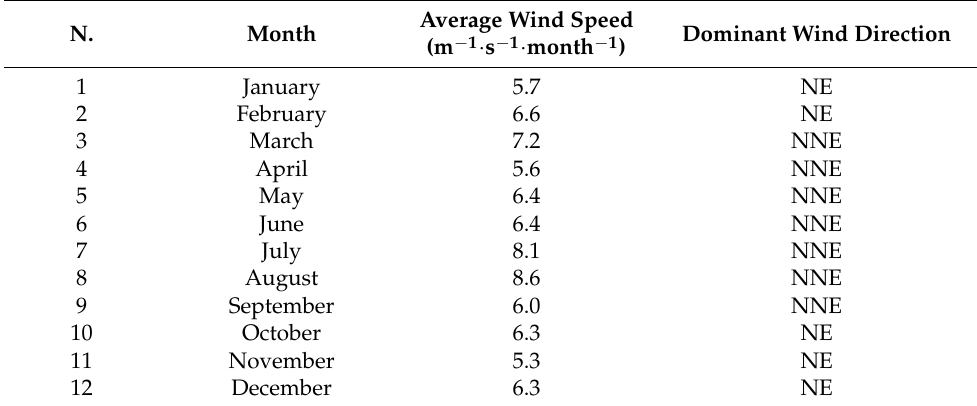
Table 4. Annual average wind speed in Lanzarote in 2020 [21].